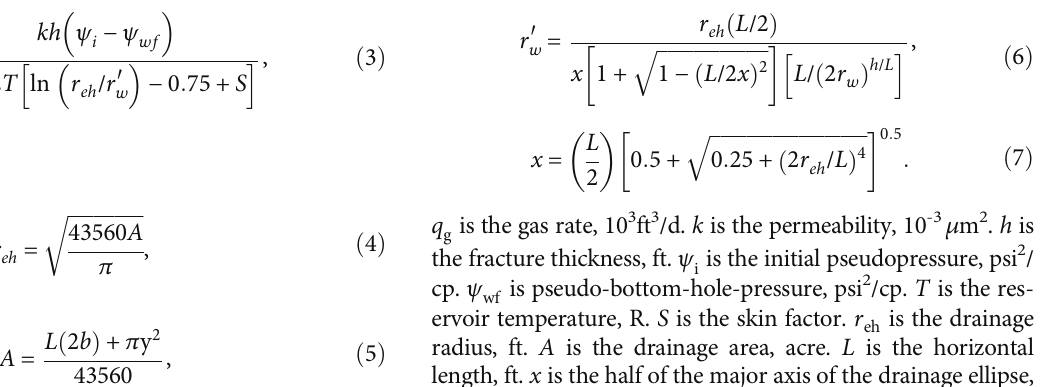
Figure 5: Relationship between gas rate and horizontal length in di ff erent